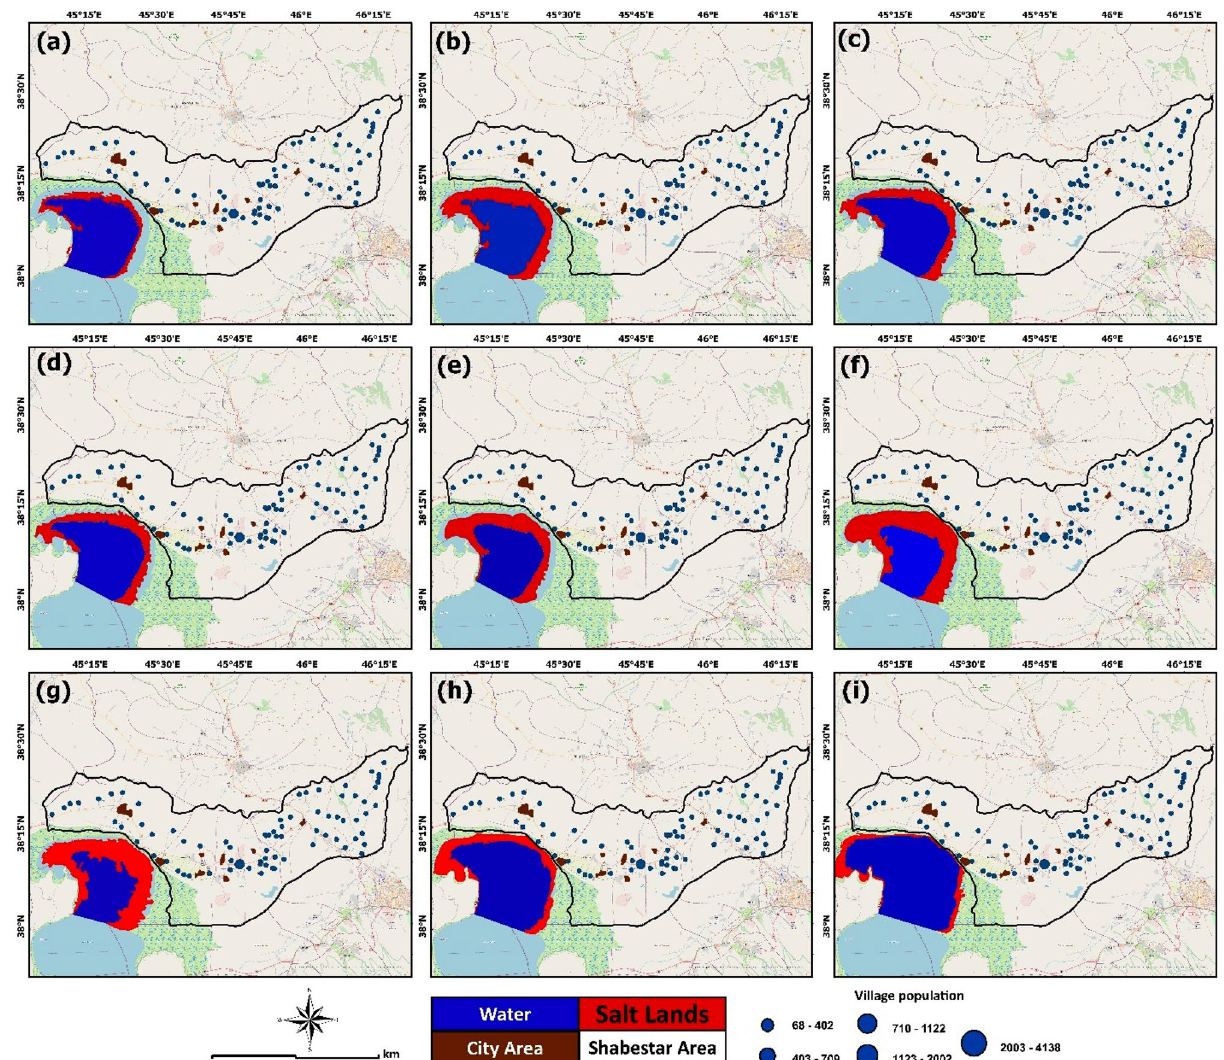
Figure 6. Results of Lake Urmia drought monitoring and the extension of salt-dust scatter sources around the lake in: ( a ) 2012, ( b ) 2013, ( c ) 2014, ( d ) 2015, ( e ) 2016, ( f ) 2017, ( g ) 2018, ( h ) 2019, and ( i ) 2020. These maps are based on the time-series satellite images and remote sensing change detection analysis. The map is created in ESRI- Arc GIS version 10.7 under licenses of Humboldt-Universität zu Berlin (https:// deskt op. arcgis.